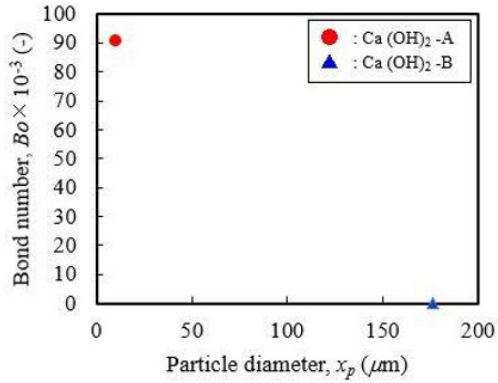
Fig. 2. Relation of the Bond number and the particle diameter .